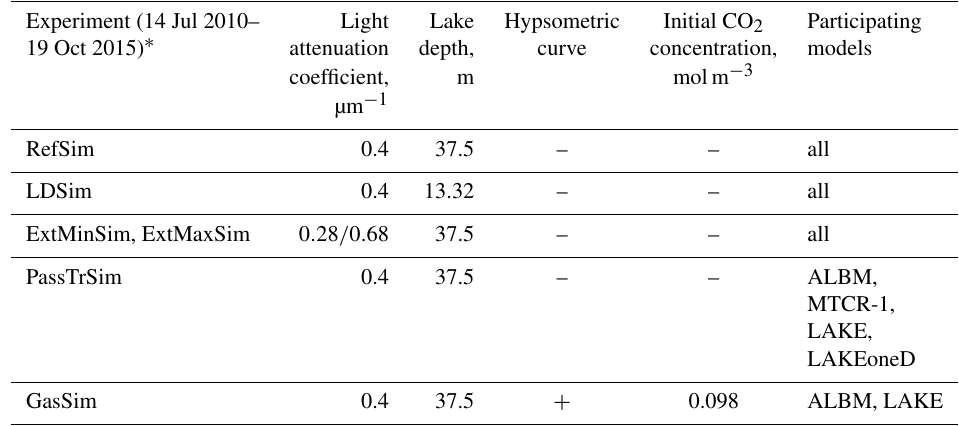
Table 3. Parameters of numerical experiments of